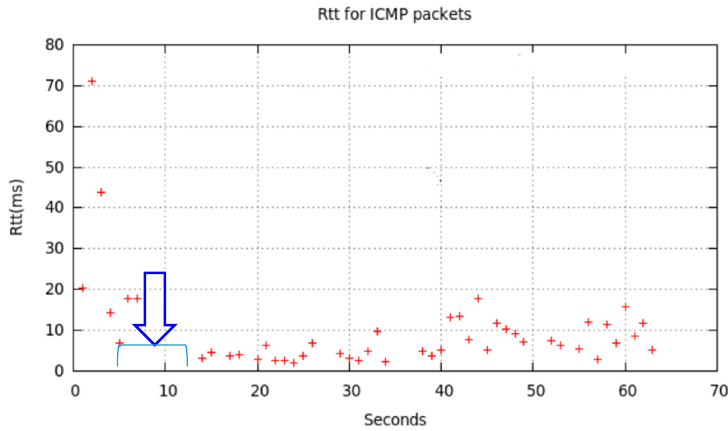
Figure 17. Effect on LFT packet sequence between node6 and node1.